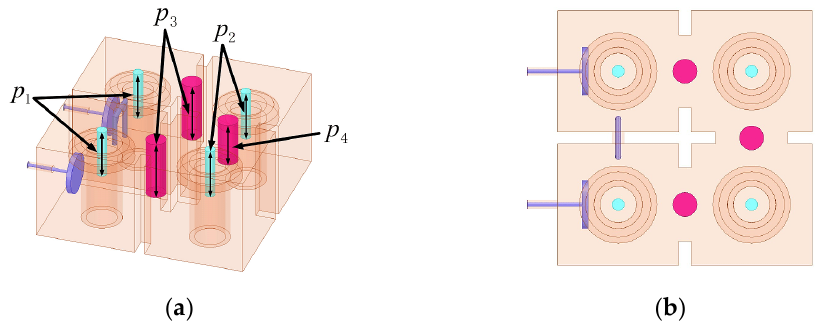
Figure 7. Fourth-order cavity filter. ( a ) Side view. ( b ) Top view.